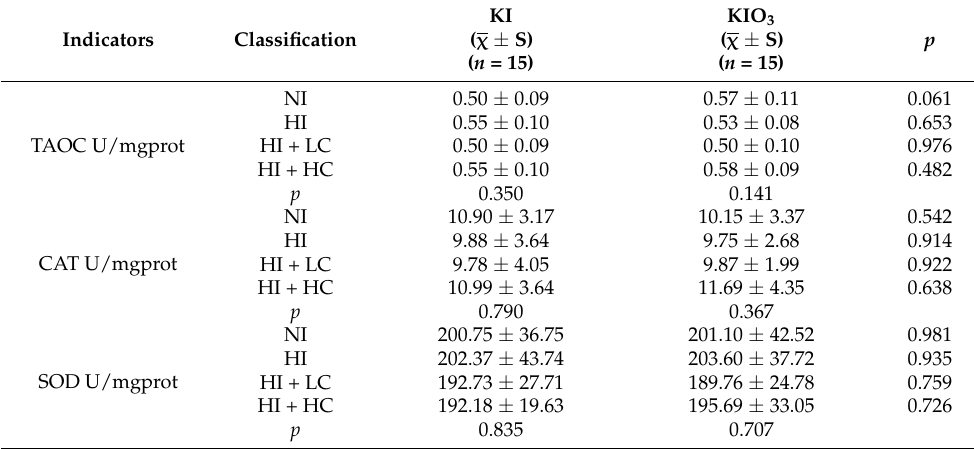
Figure 3. Protection of vitamin C from oxidative damage in the kidney for different sexes. ( A ) The activity of TAOC; ( B ) The activity of CAT; ( C ): The activity of SOD; ( D ) The content of MDA; ( E ) The activity of GSH-Px. All data are presented as mean and deviation. ** represents p < 0.01, and * represents p < 0.05. Table 3. Protection of vitamin C from oxidative damage in